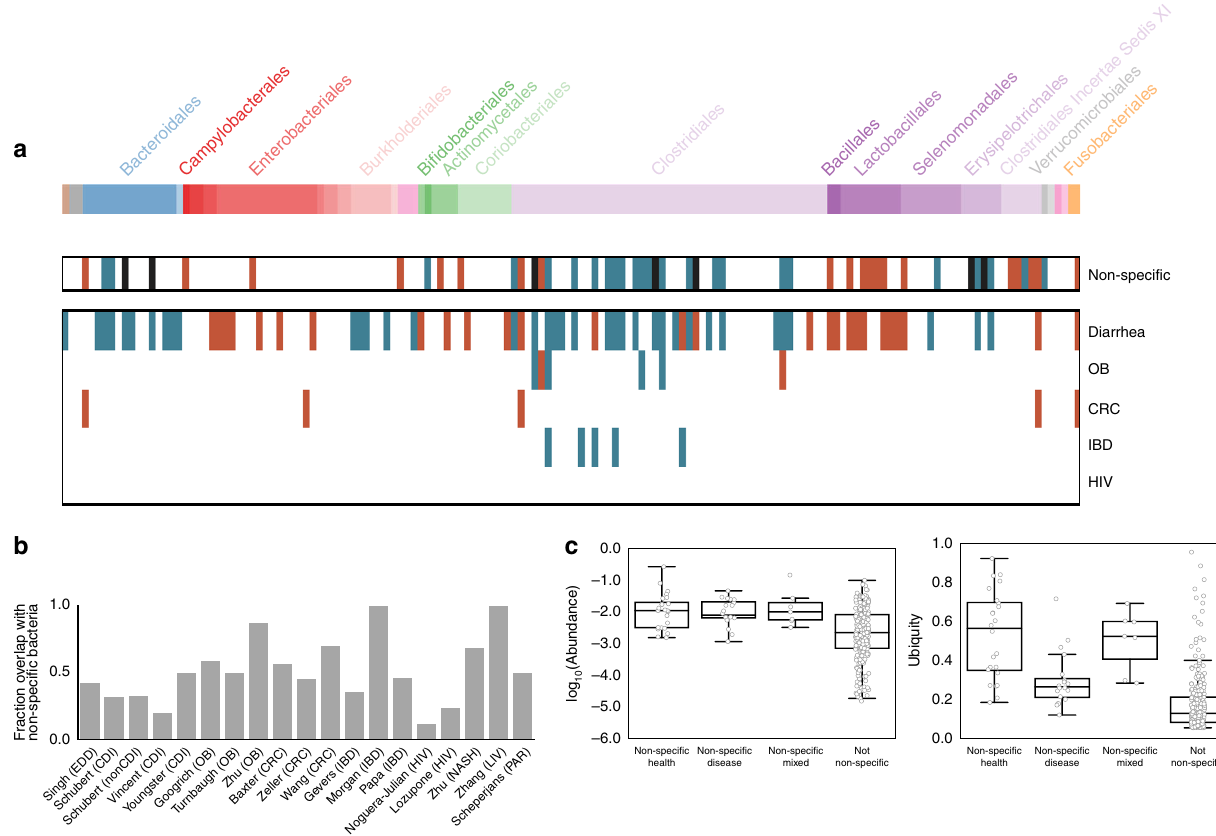
Fig. 3 The majority of disease-associated microbiome associations overlap with a non-speci fi c microbial response to disease. a Non-speci fi c and disease- associated genera. Genera are in columns, arranged phylogenetically according to a PhyloT tree built from genus-level NCBI IDs (http://phylot.biobyte.de). Non-speci fi c genera are associated with health (or disease) in at least two different diseases ( q < 0.05, KW test, Benjamini – Hochberg FDR correction). Disease-speci fi c genera are signi fi cant in the same direction in at least two studies of the same disease ( q < 0.05, FDR KW test). As in Fig. 2, blue indicates higher mean abundance in controls and red indicates higher mean abundance in patients. Black bars indicate mixed genera which were associated with health in two diseases and also associated with disease in two diseases. Disease-speci fi c genera are shown for diseases with at least three studies. Phyla, left to right: Euryarchaeota (brown), Verrucomicrobia Subdivision 5 (gray), Candidatus Saccharibacteria (gray), Bacteroidetes (blue), Proteobacteria (red), Synergistetes (pink), Actinobacteria (green), Firmicutes (purple), Verrucomicrobia (gray), Lentisphaerae (pink), Fusobacteria (orange). See Supplementary Fig. 3 for genus labels. b The percent of each study ’ s genus-level associations which overlap with the shared response ( q < 0.05, FDR KW test). Only data sets with at least one signi fi cant association are shown. c Overall, abundance and ubiquity of non-speci fi c genera across all patients in all data sets. Non- speci fi c genera on the x -axis are as de fi ned